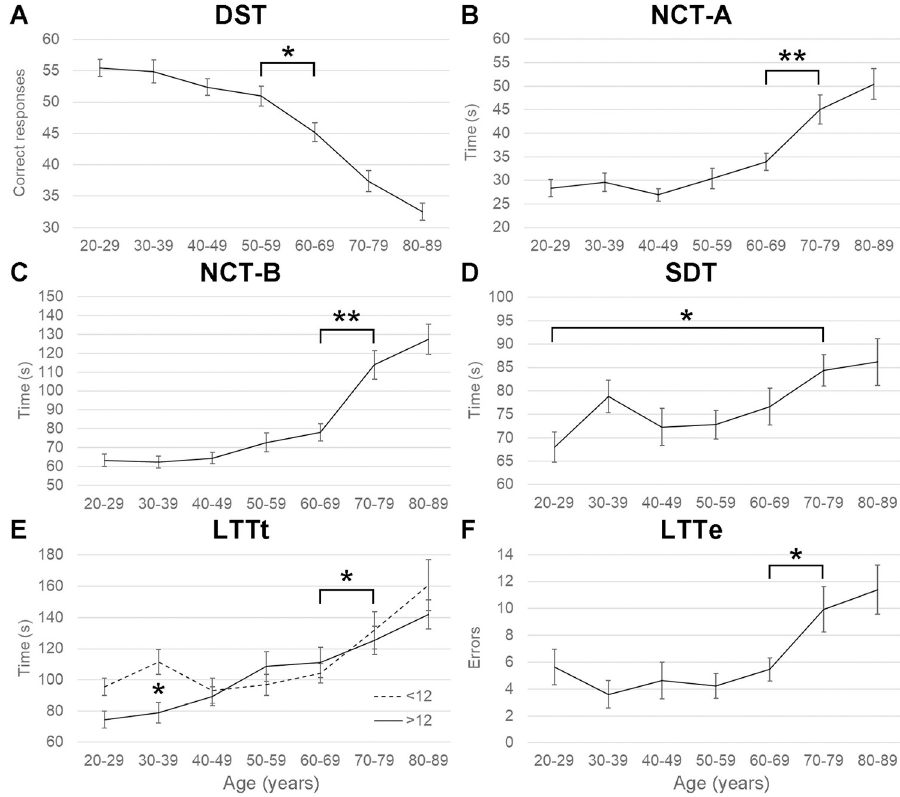
Fig 1. Effect of age on PHES. Plots of (A) correct responses in Digit Symbol Test (DST), time in seconds in (B) Number Connection Test part A (NCT-A), (C) NCT-B, (D) Serial Dotting Test (SDT), (E) Line Tracing Test (LTTt), and (F) errors in LLT (LTTe) on the y axis as a function of age levels on the x axis in years. Education is also illustrated in (E). Asterisks indicate significant statistical differences in Newman-Keuls post-hoc test: � , P < .05; �� , P < .01.